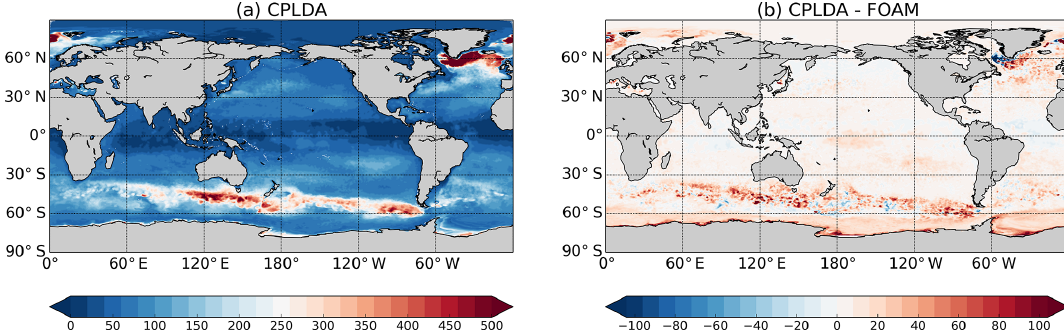
Figure 8. Annual mean Kara mixed layer depth in metres (Kara et al., 2000, using a temperature criterion of 0.8 ◦ C): (a) CPLDA and (b) the difference between CPLDA and FOAM. Positive value means CPLDA MLD is deeper than FOAM